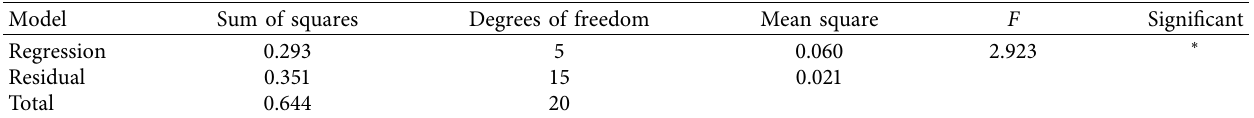
Table 9: Table of variance analysis.